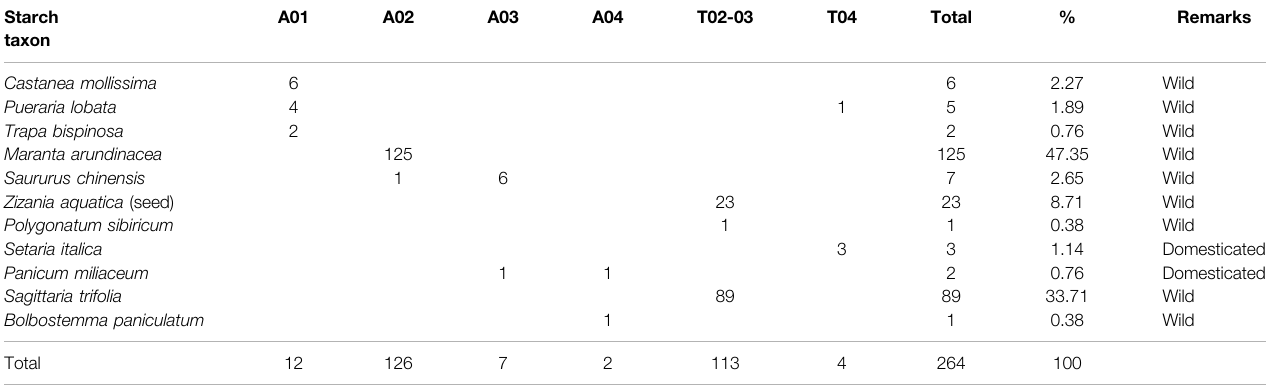
TABLE 3 | Positively identi fi ed plant taxa (SVM model accuracy ≥ 95%) from the Dingsishan site. Starch taxon